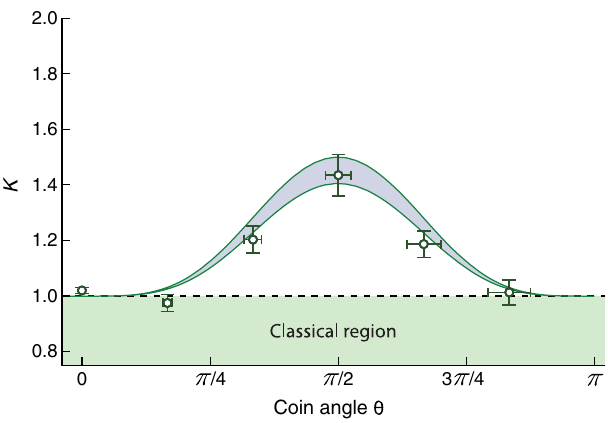
FIG. 4. Leggett-Garg correlation measurement witnessing the degree of quantumness. Maximum violation occurs for a fair coin ( θ ¼ π = 2 ), while no violation occurs for classical transport at θ ¼ 0 and θ ¼ π . The solid line is the theoretical prediction based on quantum mechanics of the LG correlation function K for a decoherence-free quantum walk (upper curve) and for a quantum walk with 10% decoherence per step (lower curve). The vertical error bars represent 1 σ uncertainty, while the horizontal error bars denote a systematic uncertainty on the coin